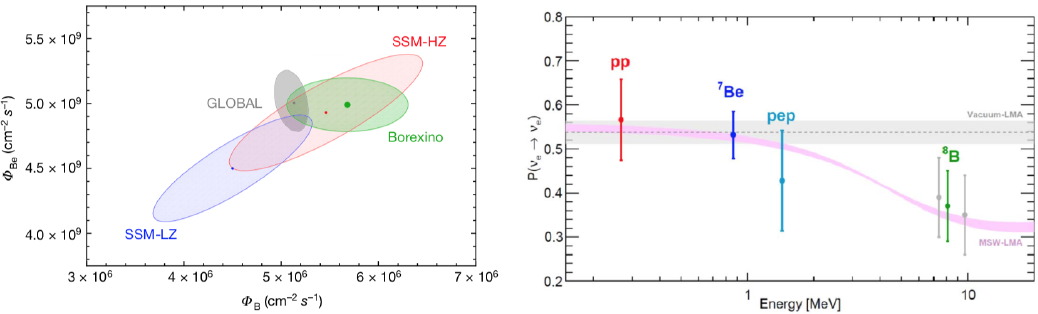
Figure 6: Left: Phase-II Borexino and solar neutrino experiments 7 Be and 8 B solar neutrino results compared against theoretical predictions from HZ and LZ SSM. El- lipses indicate 1 σ contours. Right: the electron flavor survival probability of the solar neutrino components measured with Borexino. The pink band represents the energy-dependent survival probability under the assumption of HZ